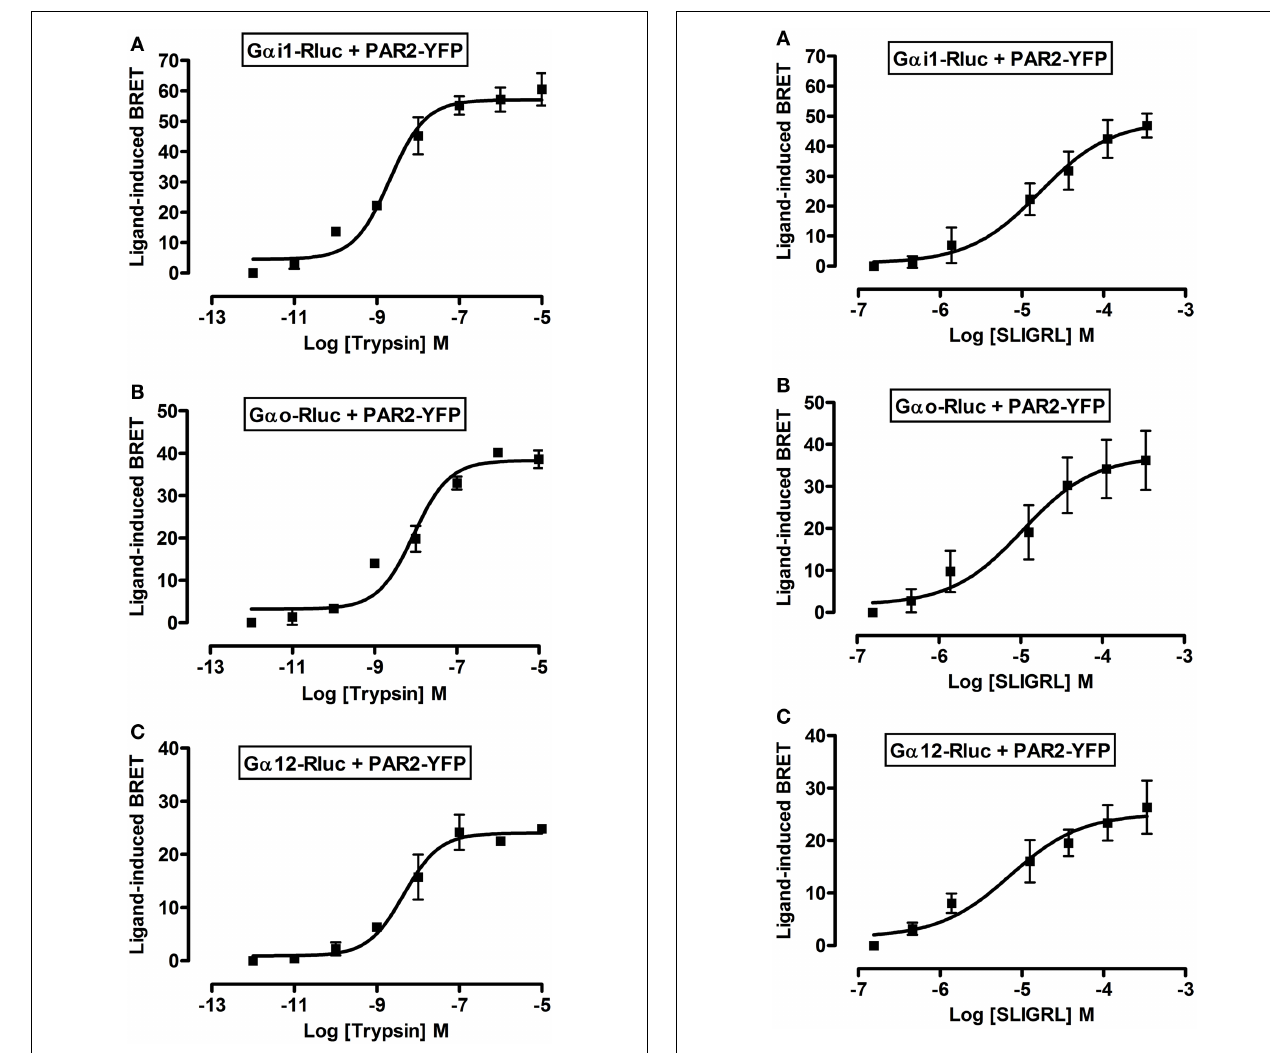
FIGURE 4 | Dose-response analysis of trypsin-induced BRET increase between PAR2 and G α proteins . COS-7 cells transiently co-expressing PAR2-YFP and either G α i1-Rluc (A) , G α o-Rluc (B) , or G α 12-Rluc (C) were used for BRET experiments in the presence of increasing concentrations of trypsin as indicated. Data are means ± SEM of three independent experiments performed in duplicate.